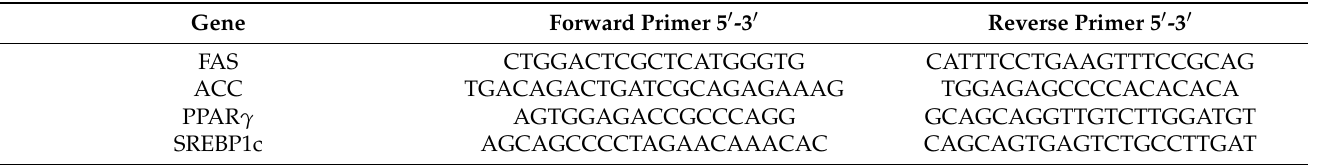
Table 2. Primer sequences for